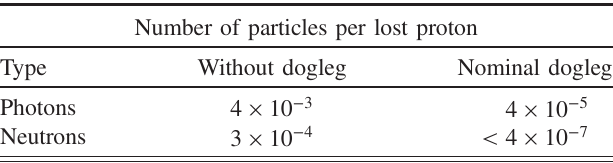
TABLE V. Rate of neutral particles hitting the first main dipole aperture, with and without the dogleg.